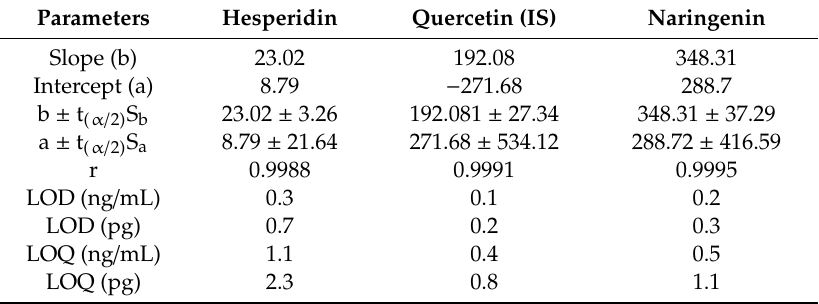
Table 1. Calibration parameters for hesperidin, quercetin, and naringenin. Parameters Hesperidin Quercetin (IS) Naringenin Slope (b)